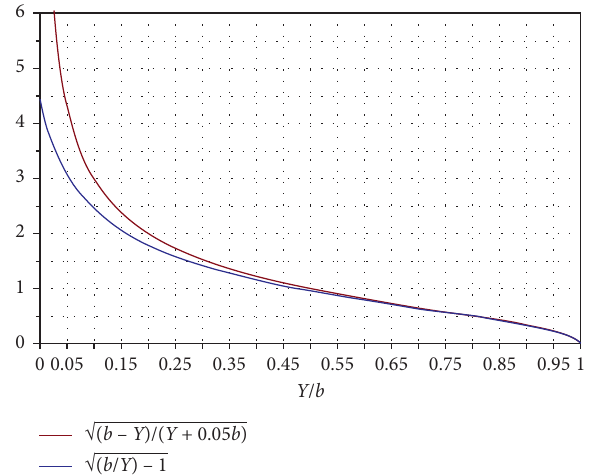
Figure 11: Correction of the coefficient of the aerodynamic force.